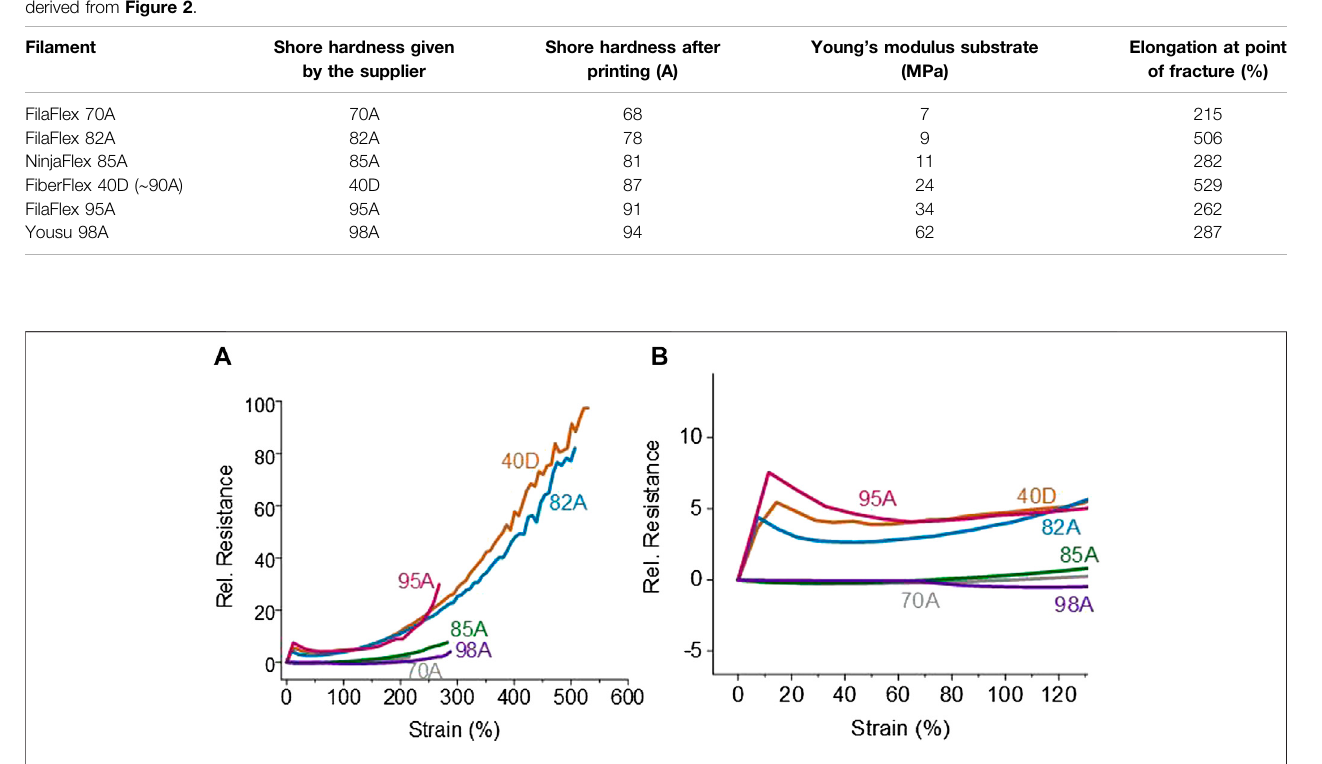
Frontiers in Robotics and AI |